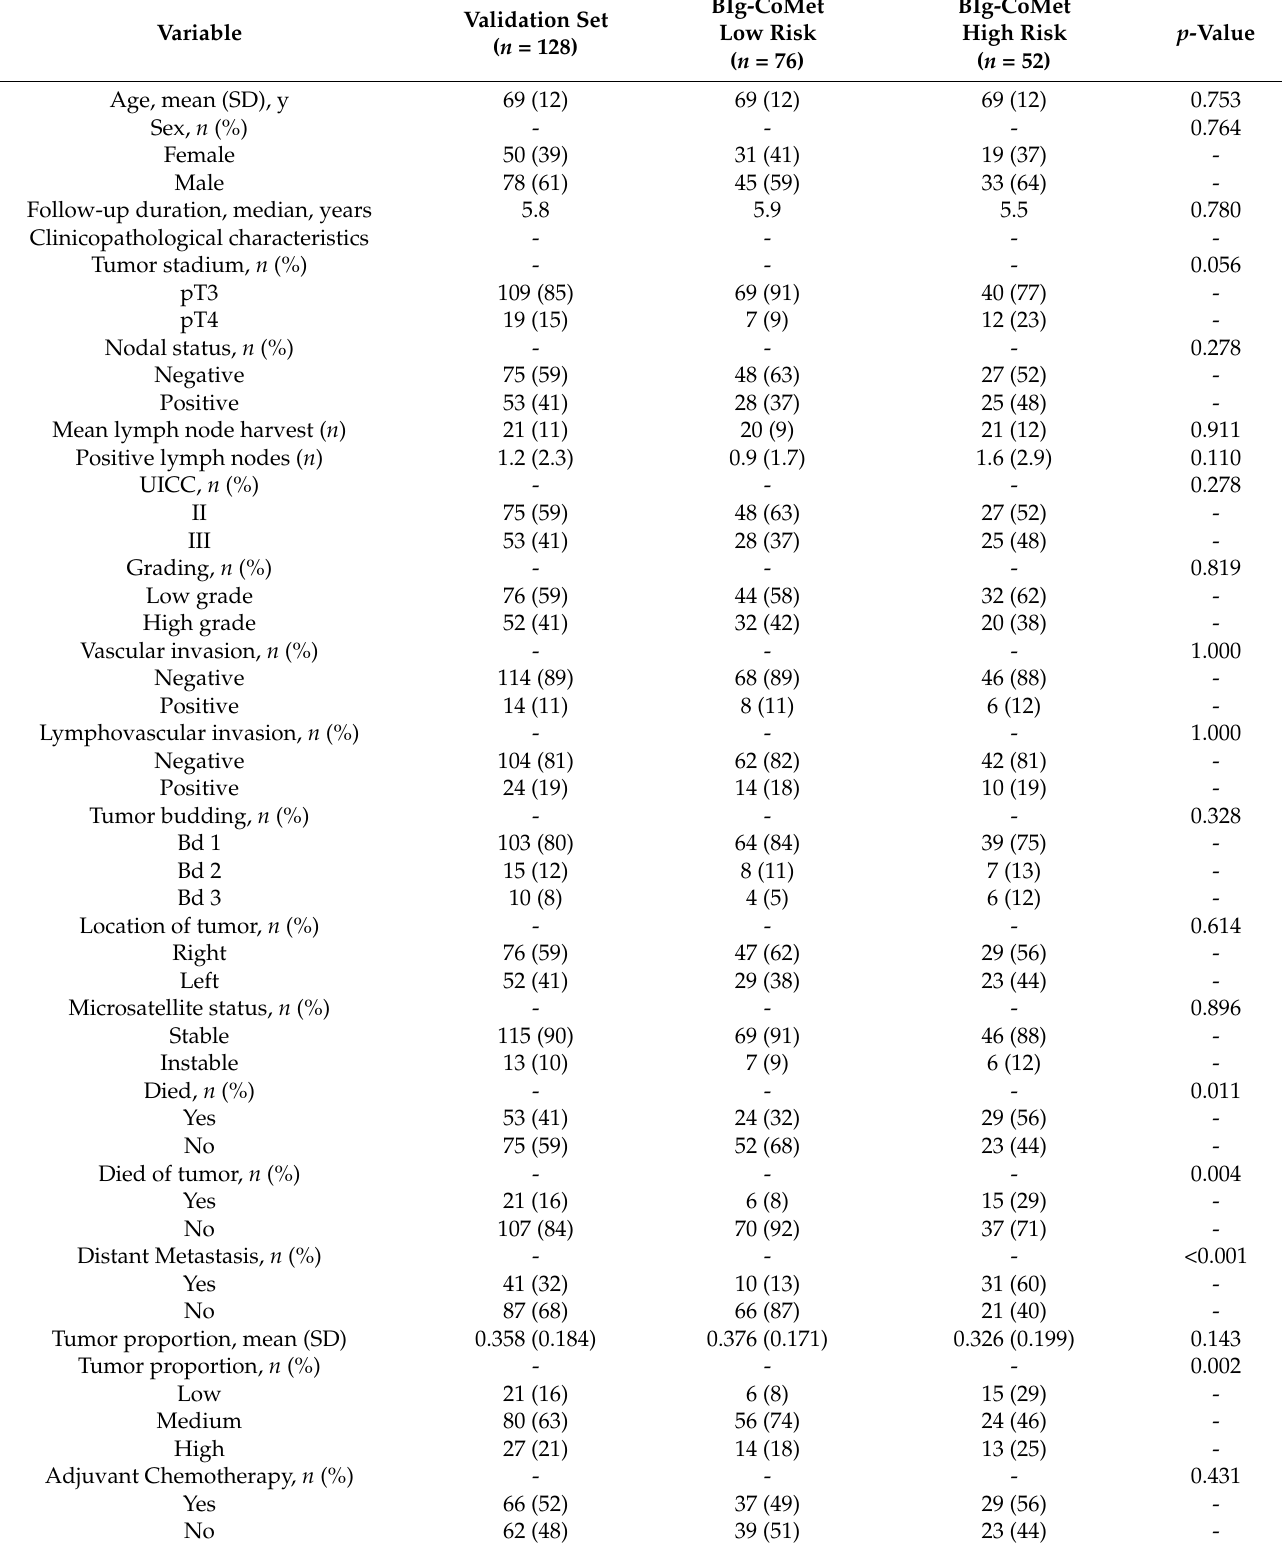
Table 1. Patient characteristics (validation set) and different BIg-CoMet risk